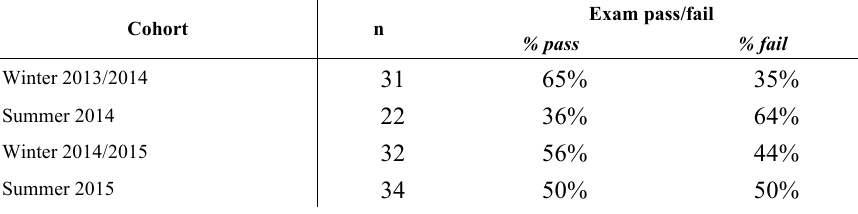
Table 2. Mathematics placement test scores by cohort